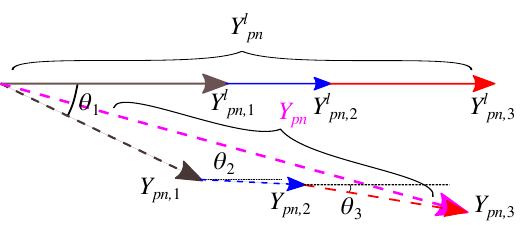
Figure 9. Off-diagonal element aggregation of substations.